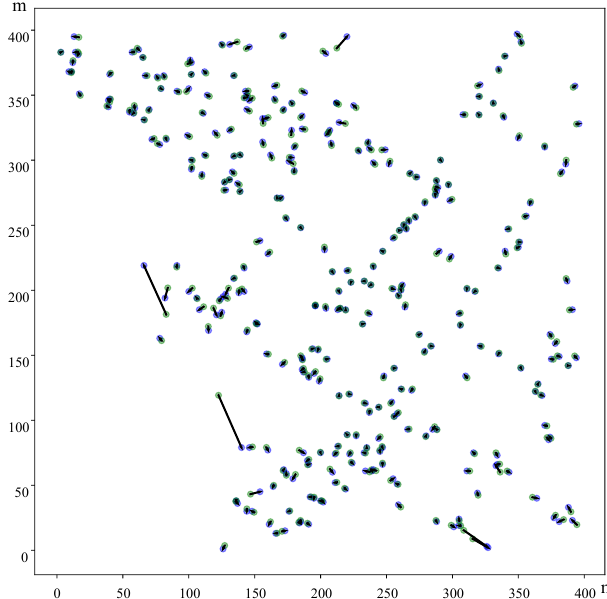
Figure 4. Error visualization of 300 randomized testing samples. The green points represent the reference locations, and the blue points denote the locations predicted by the proposed method. The black lines represent the deviation between the reference locations and predicted